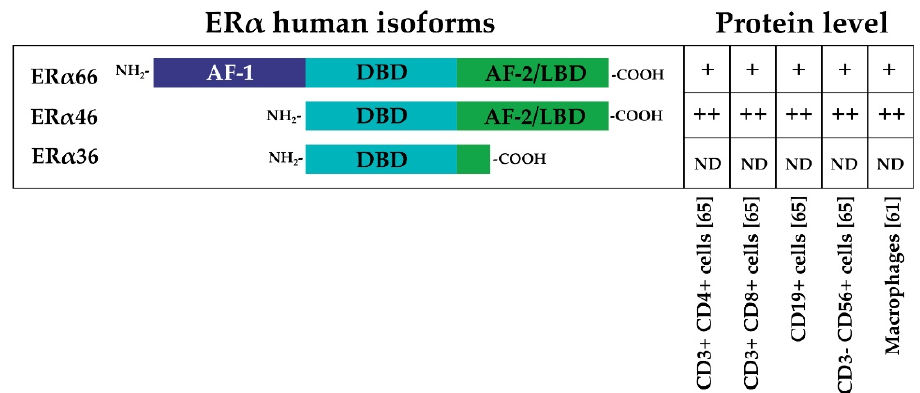
Figure 2. The three main different isoforms of ER α are presented: the full-length 66 kDa ER α (ER α 66), the AF-1 domain-truncated 46 kDa variant of ER α (ER α 46), and a 36 kDa ER α variant (ER α 36) that lacks both AF-1 and AF-2 domains [43–45]. The relative protein levels in different immune system cells are indicated by ++, +, or ND (not detected) [61,65].